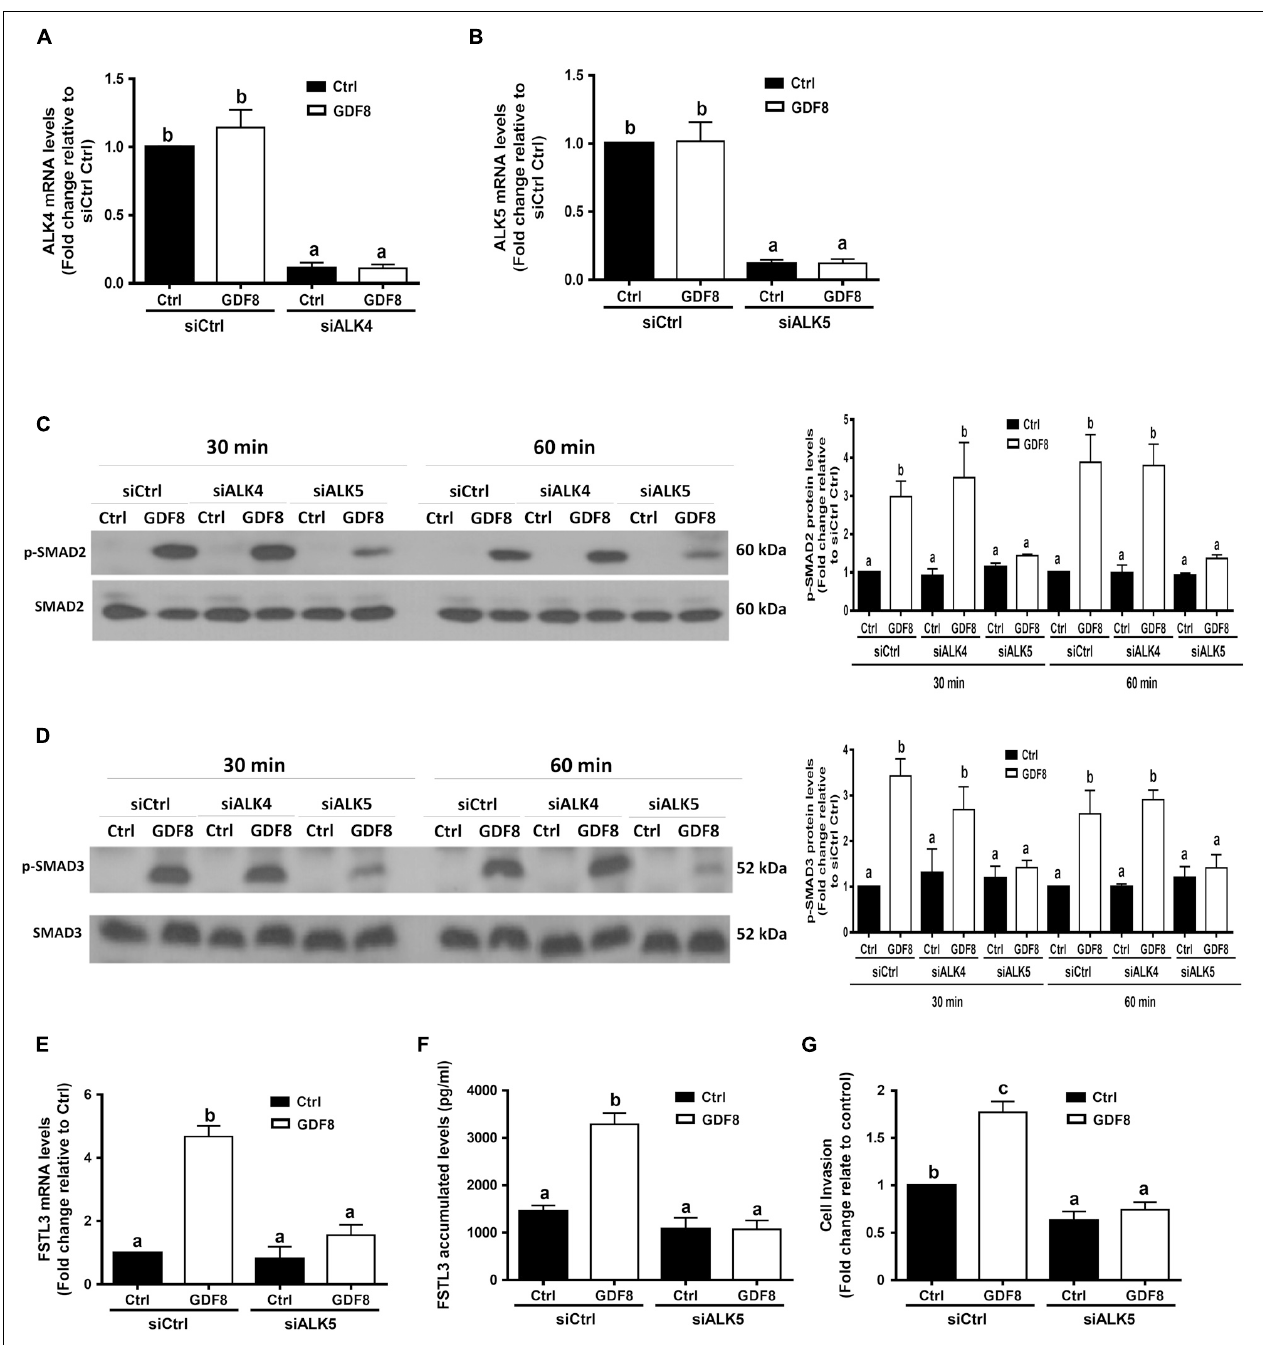
FIGURE 5 | ALK5 mediates the growth differentiation factor 8 (GDF8)-induced increase in phosphorylated protein levels of SMAD2/3 and cell invasion in HTR8/SVneo cells. (A,B) HTR8/SVneo cells were transfected for 24 h with 20 nM non-targeting control siRNAs (siCtrl), 20 nM siRNAs targeting ALK4 (siALK4) or 20 nM siRNAs targeting ALK5 (siALK5), after which the cells were treated with the vehicle control (Ctrl) or 25 ng/mL GDF8 for 24 h; the mRNA levels of ALK4 (A) and ALK5 (B) were examined using RT-qPCR. (C,D) HTR8/SVneo cells were transfected for 24 h with 20 nM siCtrl, 20 nM siALK4, or 20 nM siALK5, after which the cells were treated with the vehicle control (Ctrl) or 25 ng/mL GDF8 for 30 or 60 min; the phosphorylated protein levels of SMAD2 (C) and SMAD3 (D) were examined using western blot analysis. (E–G) HTR8/SVneo cells were transfected for 24 h with 20 nM siCtrl or 20 nM siALK5, after which the cells were treated with the vehicle control (Ctrl) or 25 ng/mL GDF8 for 24 h; the mRNA (E) and accumulated (F) levels of follistatin-like 3 (FSTL3) were examined using RT-qPCR and ELISA, respectively, and cell invasion was examined using the Matrigel-coated transwell assay. SMAD2 and SMAD3 were used as the loading control and references for densitometric analysis for p-SMAD2 and p-SMAD3, respectively. The results are displayed as the mean ± SEM of at least three independent experiments, and the values with different letters are significantly different ( P < 0.05).